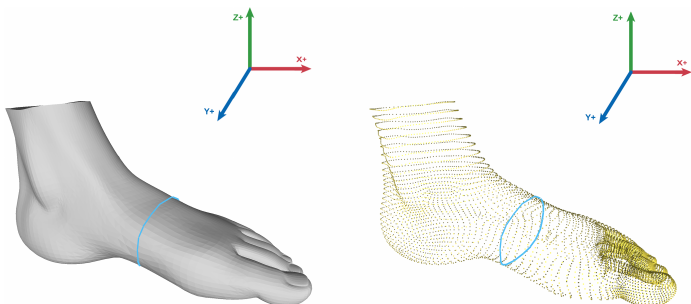
Figure 7. Instep girth measurement from 3D